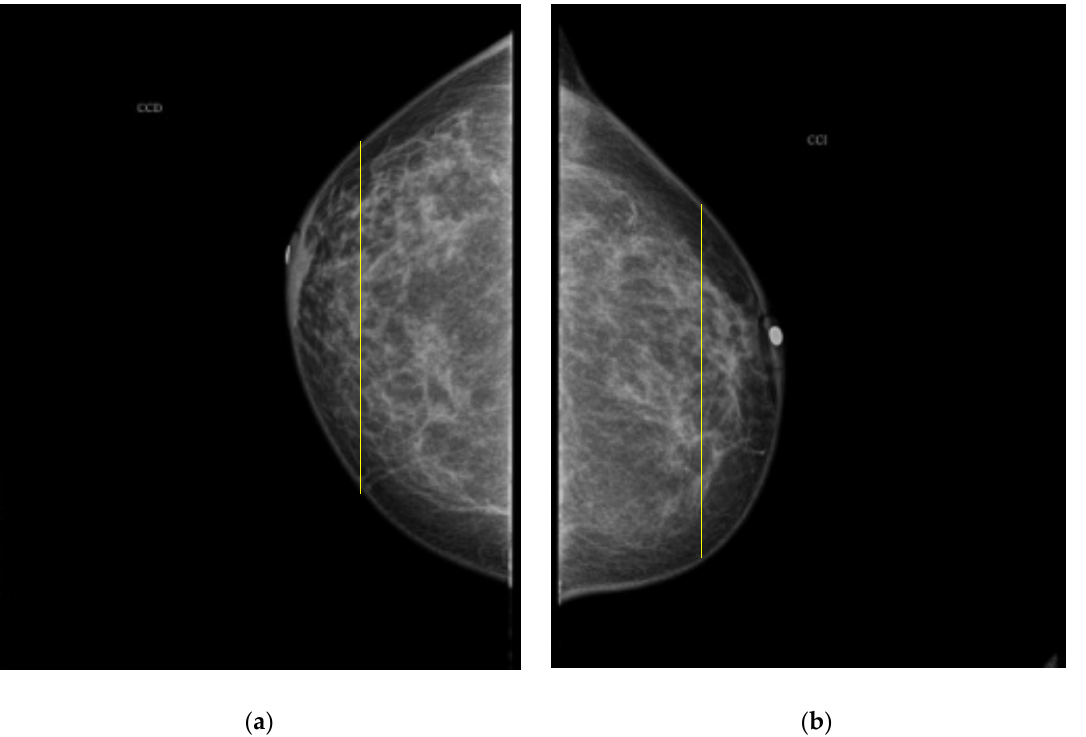
Figure 9. CC mammogram images of participant 4 and relative electrode ring position (yellow vertical line): ( a ) right breast; ( b ) left breast.